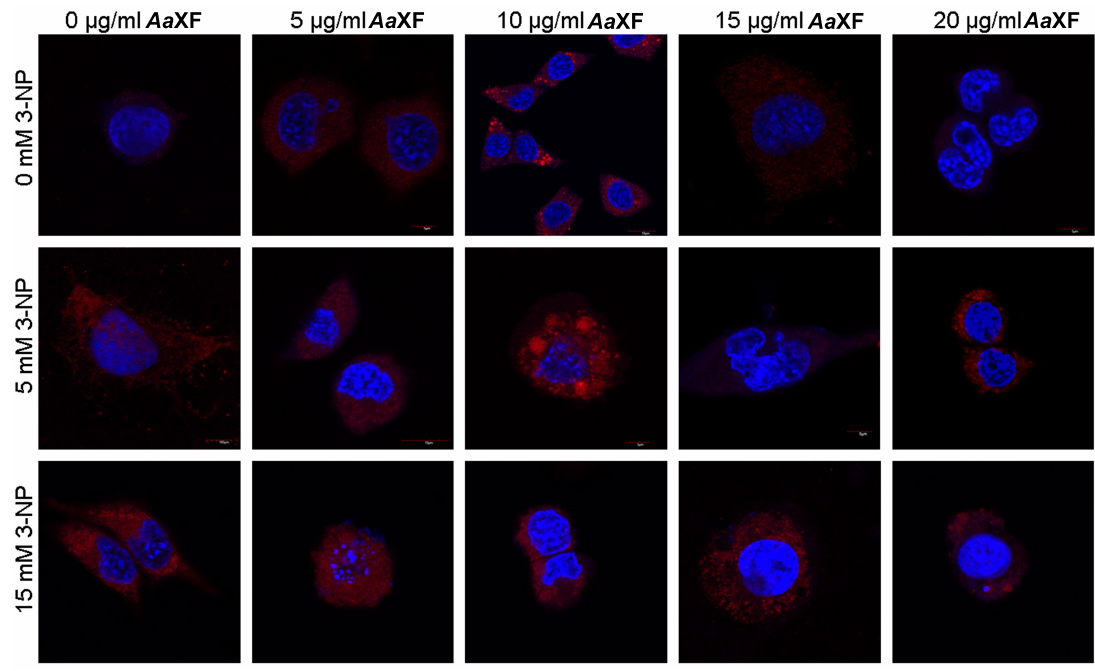
Figure 5. Confocal fluorescence analysis of PC12 cells using MitoTracker ® Deep Red FM and 4 (cid:48) ,6- diamidino-2-phenylindole (DAPI) after incubation with the xanthone fraction of Anemarrhena asphodeloides (5, 10, 15, and 20 µ g / mL) and 3-NP (5, 15 mM). Scale bar = 10 µ